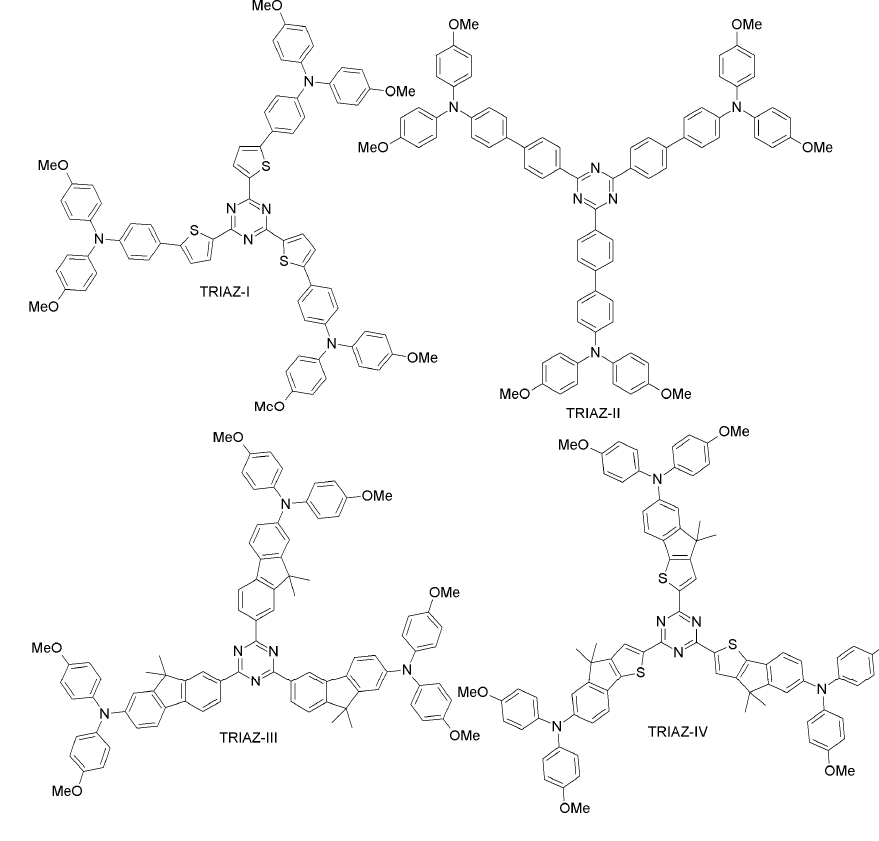
Figure 9. Triazine-based HTMs.